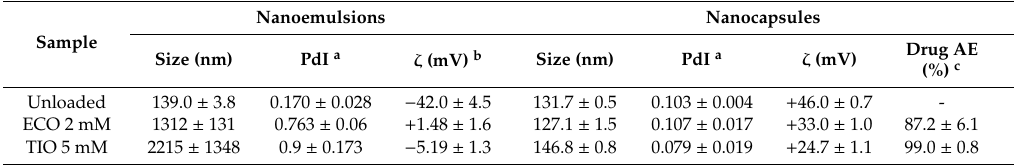
Table 1. Characteristics of formulations (mean ± SD, n = 3).